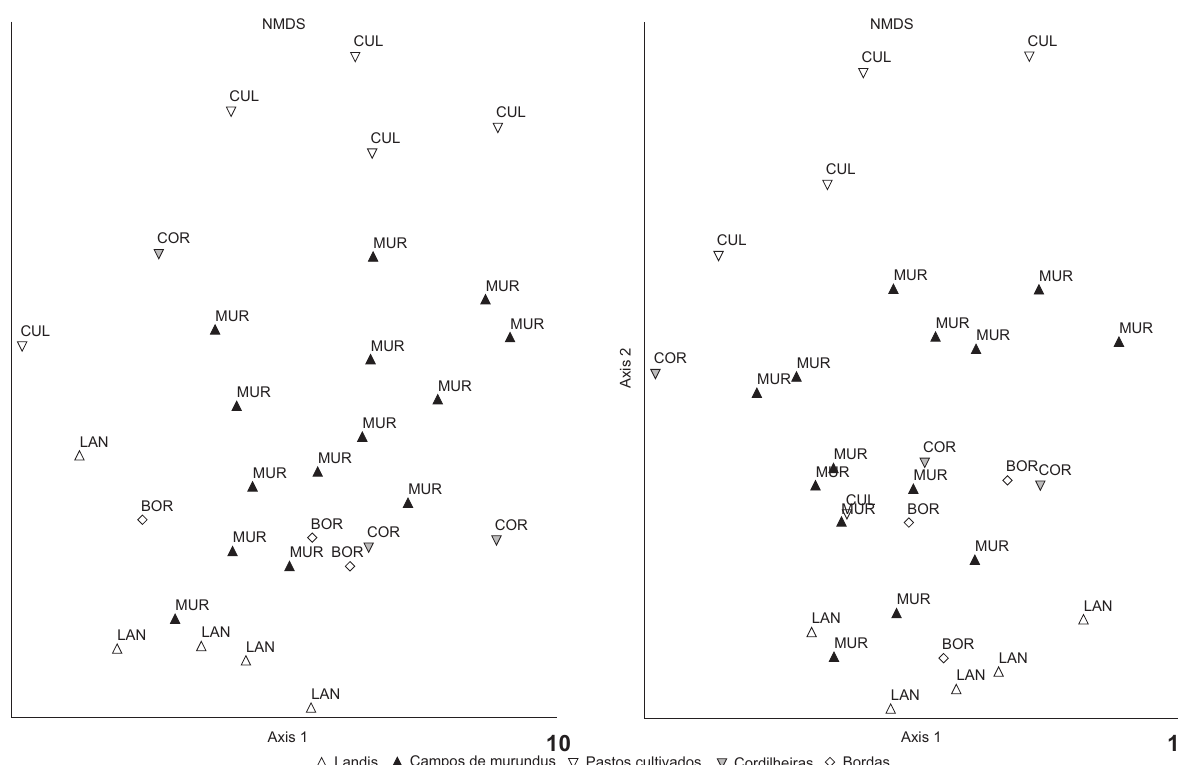
Figures 10-11. NMDS Ordination of the 30 sampling plots based on their bird species composition: (10) species presence or absence data; (11) relative